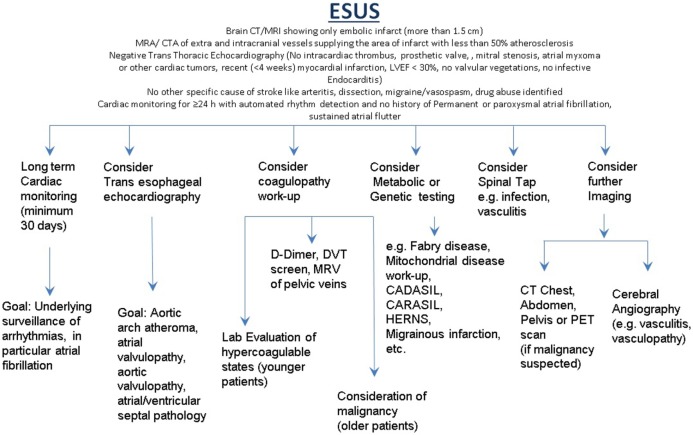
Suggested investigative approach for patients with ESUS.